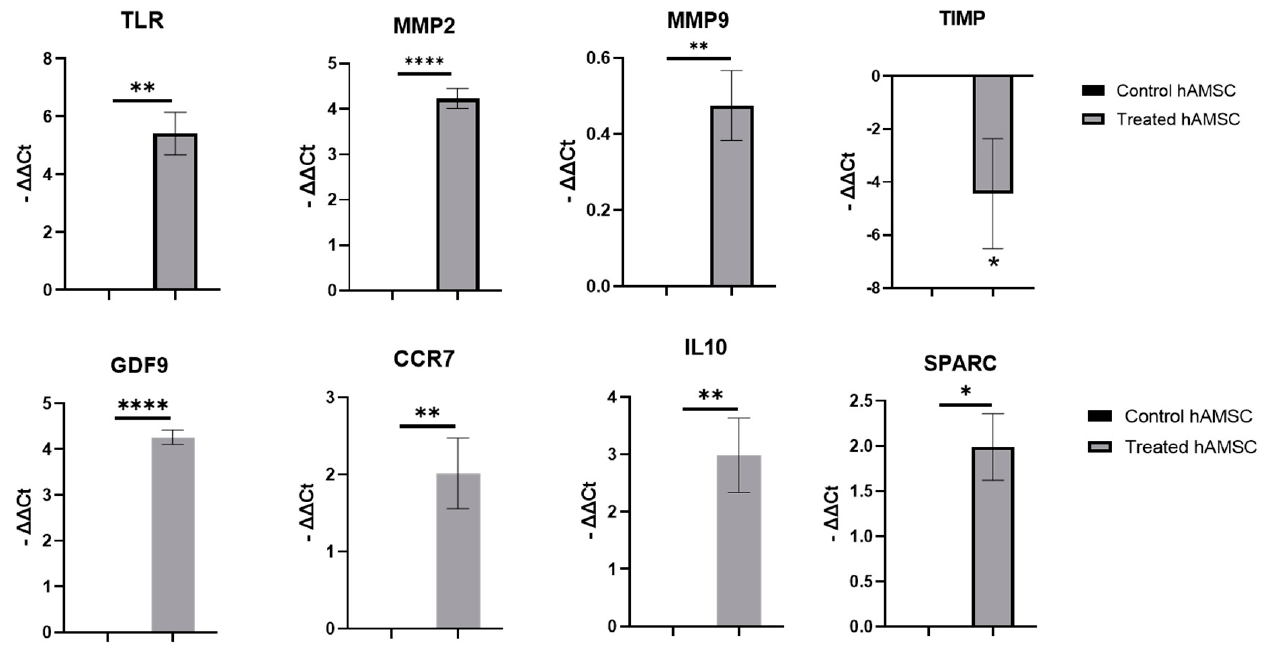
Figure 3. The comparison of expression levels of interested gene in hAMSCs with or without S100A8/A9 treatment. The significance among the groups was calculated using t test. * p < 0.05, ** p < 0.01, **** p < 0.0001.